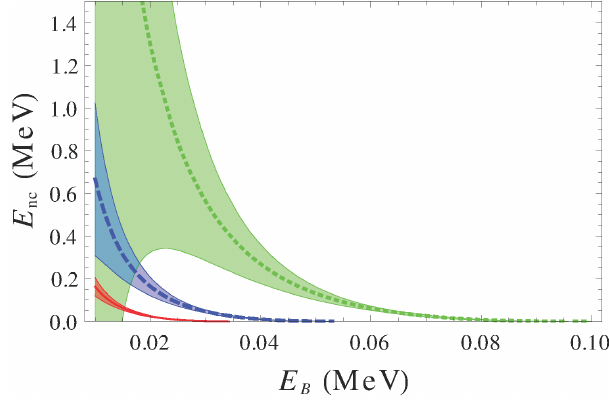
(cid:2) (cid:2) R 2 (cid:3) = 5.4 fm (blue, dashed), 6.3 fm (red, solid), and 4.5 fm (green, dotted), with their Figure 1. Plots of theoretical error bands, in the ( E B , E nc ) plane. (Published in Ref. [7].)